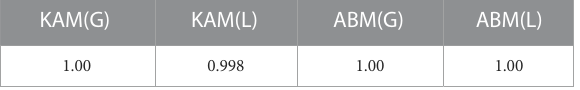
TABLE 2 Classi fi cation accuracy for test data.